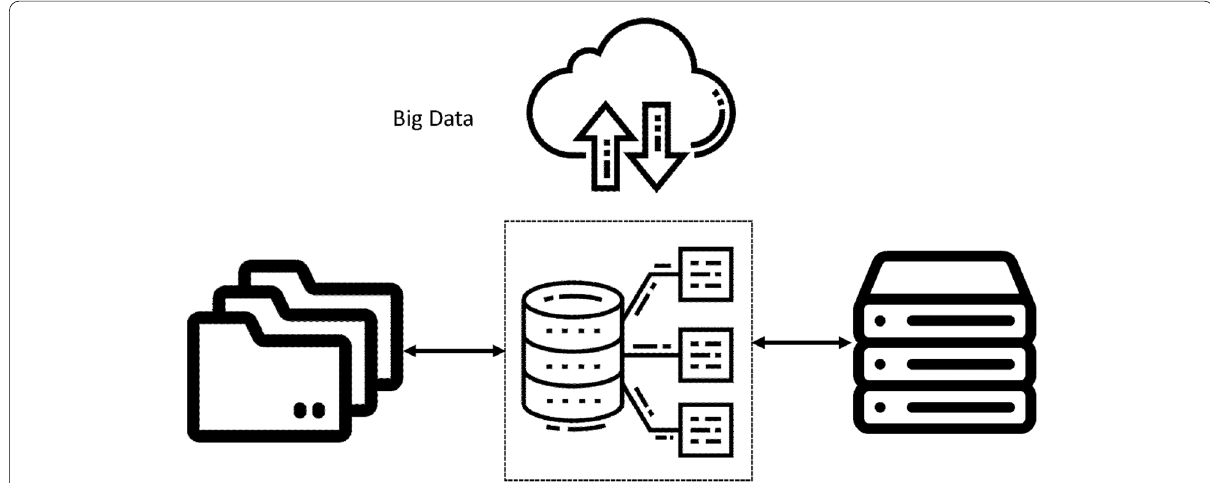
Fig. 1 Illustration of Big Data and Quality